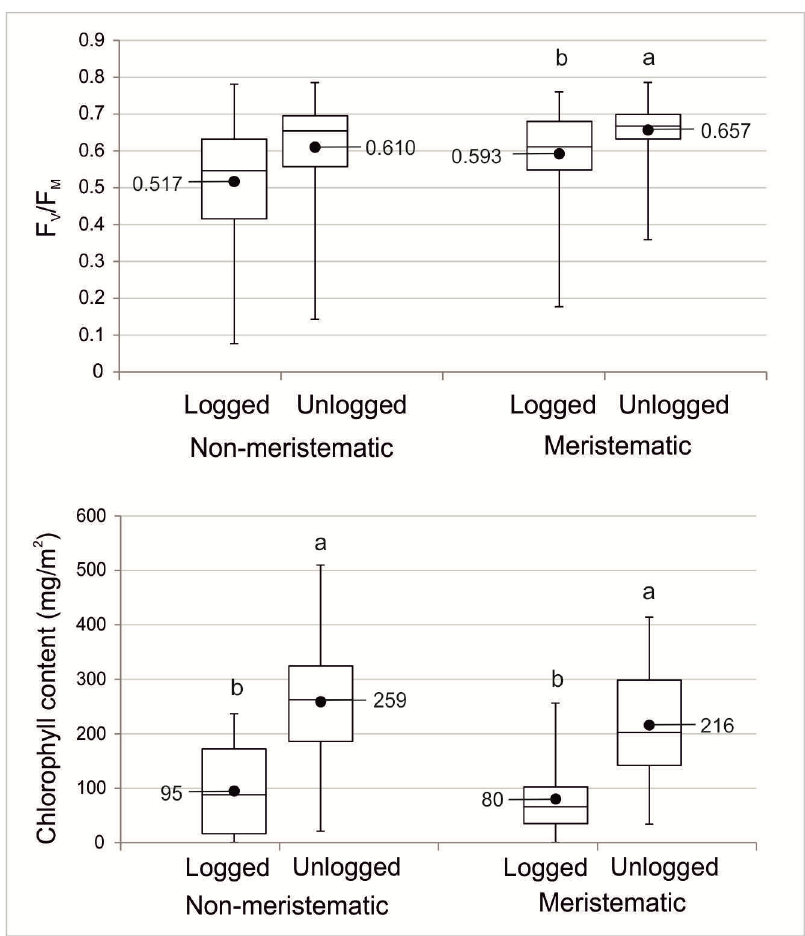
Figure 3. Boxplots of the potential quantum yield of primary photochemistry (F V /F M ) and the total chlorophyll content (mg m − 2 ) at the end of the transplant experiment as indicators of the vitality of meristematic and non-meristematic fragments, in logged and unlogged stands. The average value is shown at the side of each box. Regarding each type of fragment, different small letters indicate significant differences according to forest management ( p < 0.05).